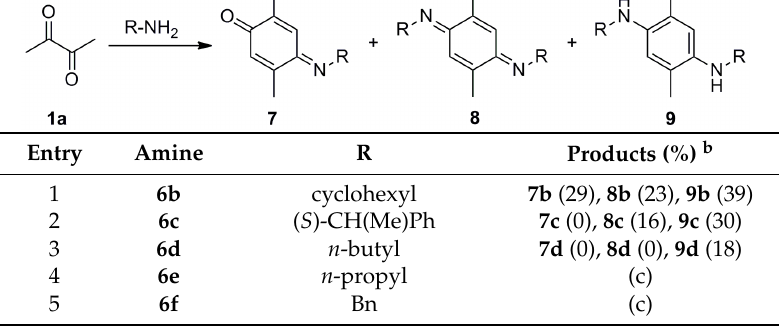
Table 2. Condensation of 1a with primary amines 6b – f a .